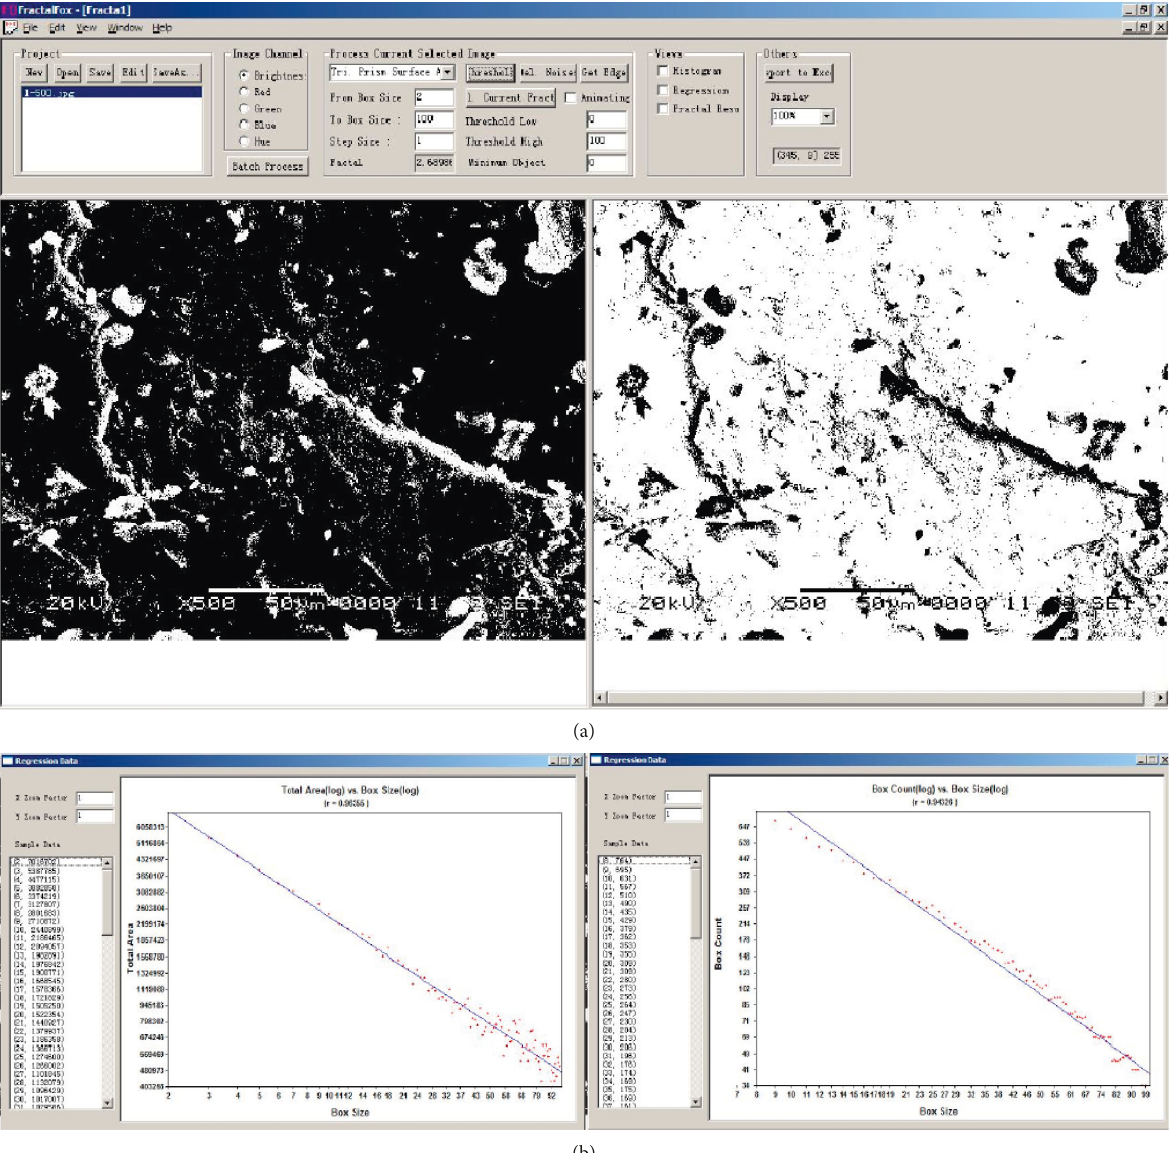
Figure 4: Calculation of the interface and pore distribution fractal dimension fitting curve using Fractal Fox 2.0 Software.